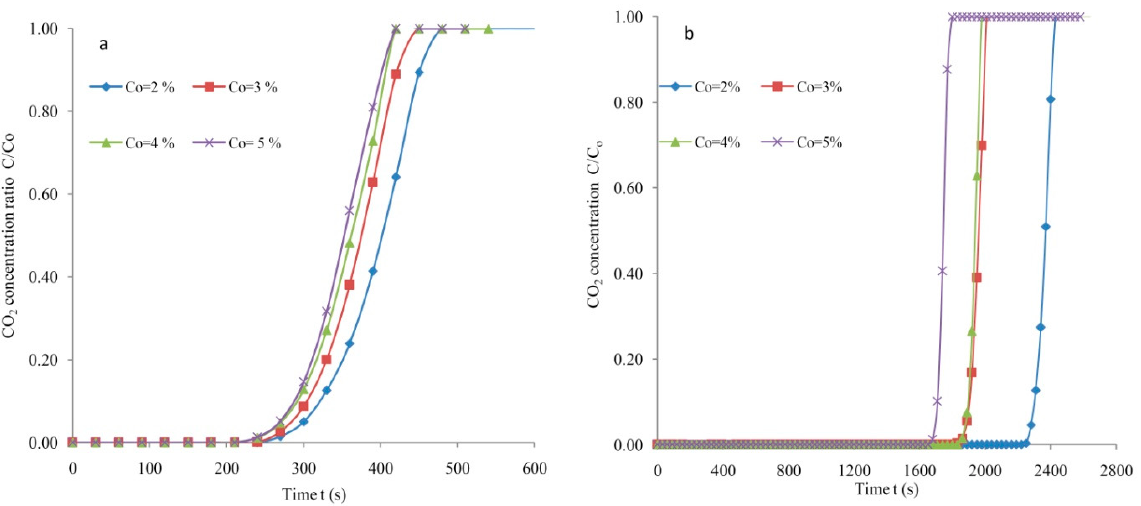
Figure 10. Adsorption responses at various CO 2 levels at F = 4 lpm, T = 298K ( a ) SG and ( b )